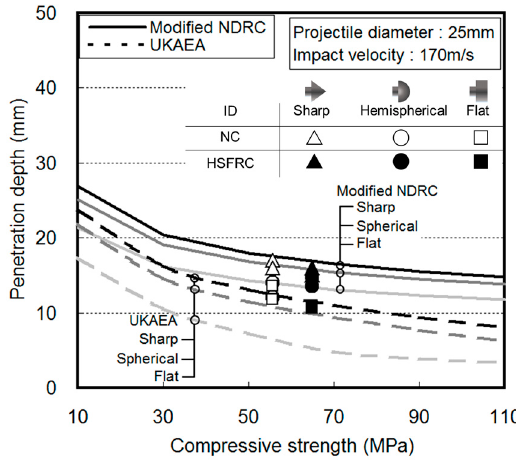
Figure 10. The experimentally observed and predicted penetration depths.